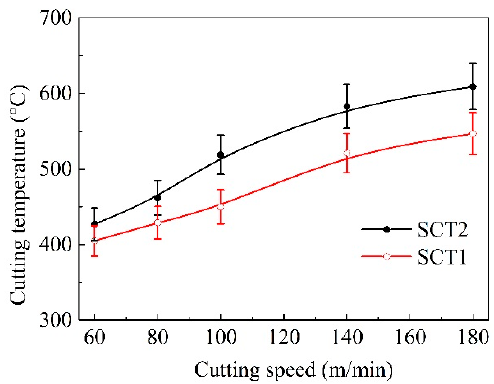
Figure 10. Cutting temperature with SCT1 and SCT2 in dry cutting of hardened steel at different cutting speeds ( a p = 0.2 mm, f = 0.1 mm/r, cutting time 5 min).